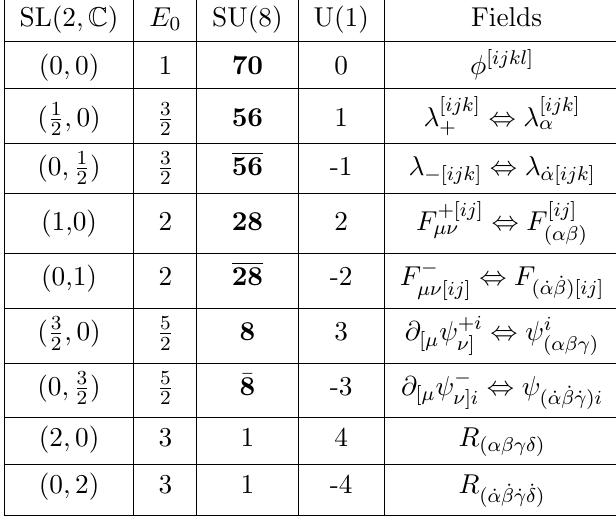
depend on vector (cid:12)eld strengths in 28 ; 16 ; 10 and 28 ; 16 ; 10 in SU(8) ; SU(6) ; SU(5) repre- sentations in N = 8 ; 6 ; 5